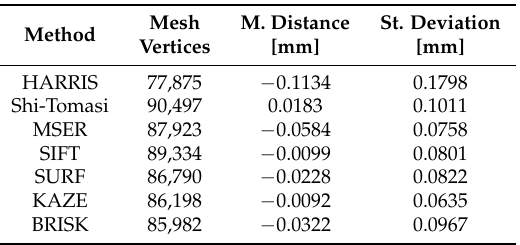
Figure 9. The signed distances of the test object for ( a ) HARRIS, ( b ) Shi-Tomasi, ( c ) MSER, ( d ) SIFT, ( e ) SURF, ( f ) KAZE, and ( g ) BRISK feature extraction methods. Table 3. The mean distance and standard deviation calculated for the polygonal models from different feature extraction